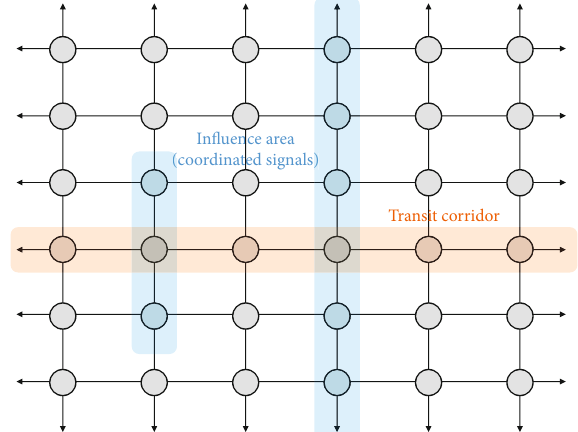
Figure 7: Adjacent intersections a ff ected by transit-signal priority. Orange-shaded area: transit corridor; blue-shaded area: in fl uence